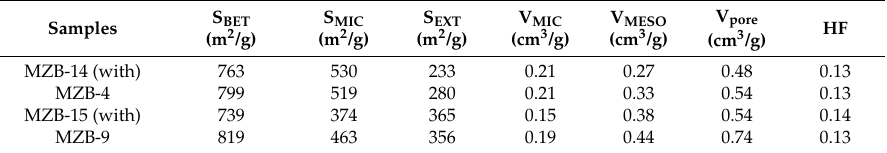
Table 4. Pore structure parameters of hierarchical Beta zeolites with and without alcohol.